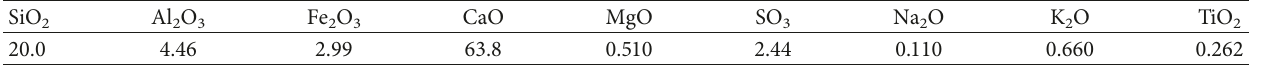
Table 1: Chemical composition (%) of cement P.II.